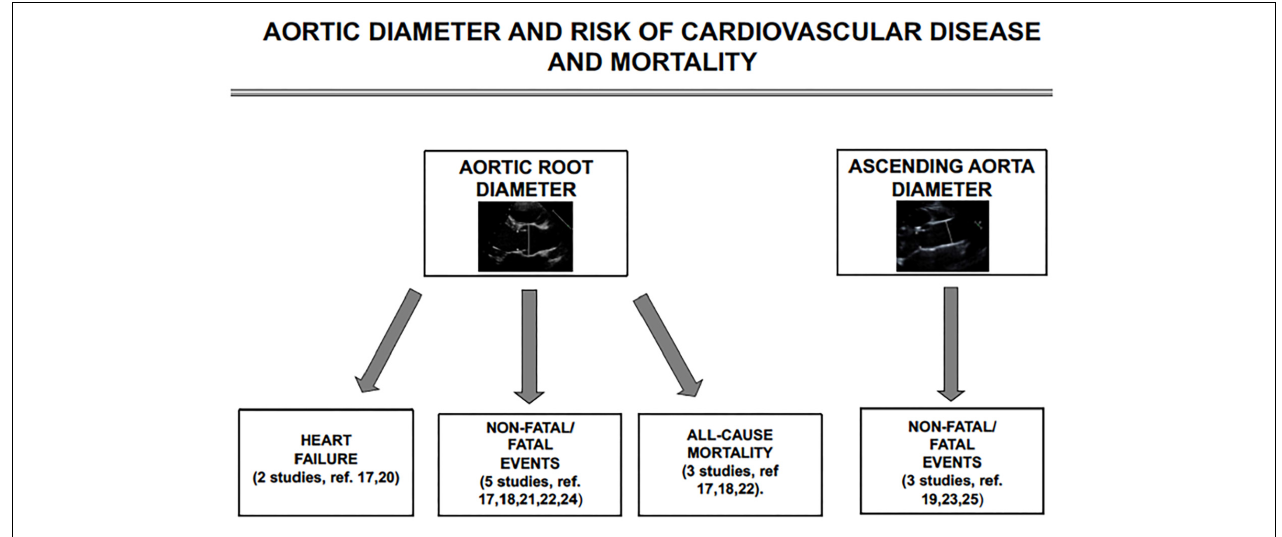
FIGURE 2 | Schematic flow-chart for studies targeting the association of aortic root and ascending aortic diameter with incident heart failure, non-fatal cardiovascular events, and all-cause